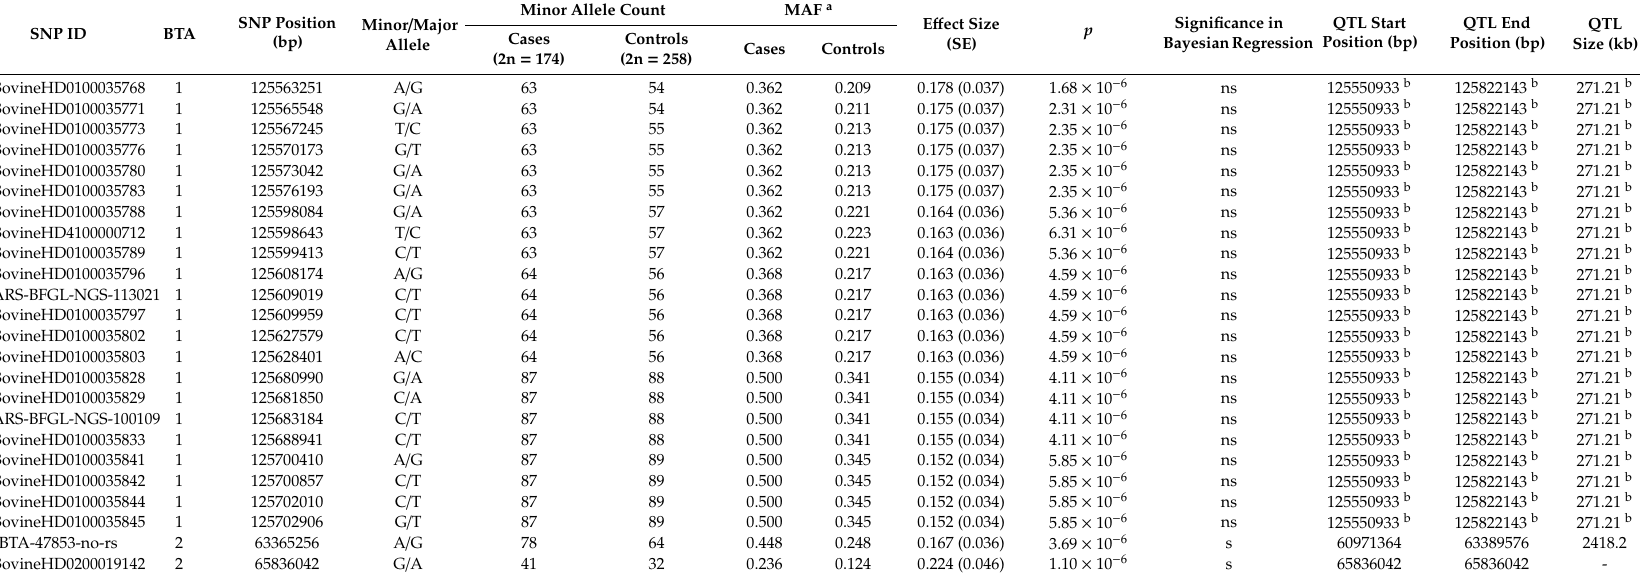
Table 2. Suggestive SNPs detected from the linear mixed model genome-wide association analysis using binary phenotypes and their defined